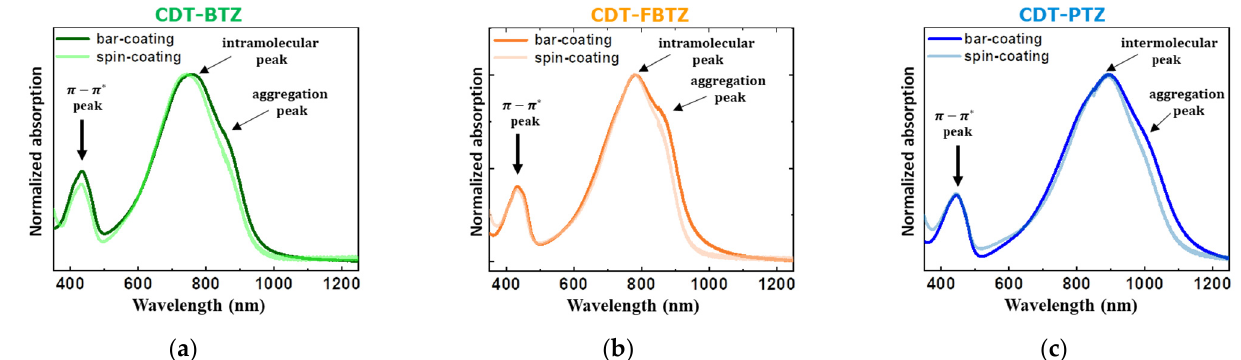
Figure 4. UV-vis absorbance spectra for spin- and bar-coated films of ( a ) CDT-BTZ, ( b ) CDT-FBTZ, and ( c ) CDT-PTZ films.